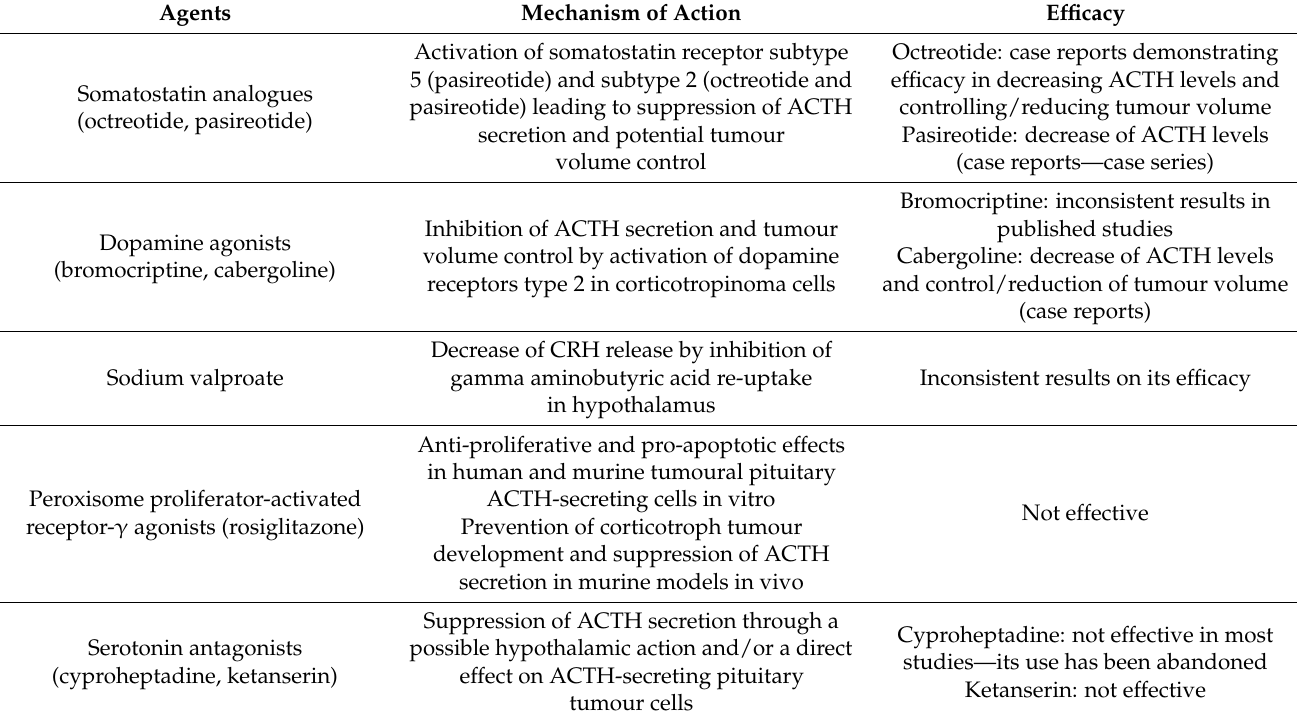
Table 2. Types, mechanism of action and reported efficacy of medical therapy in the management of Nelson’s